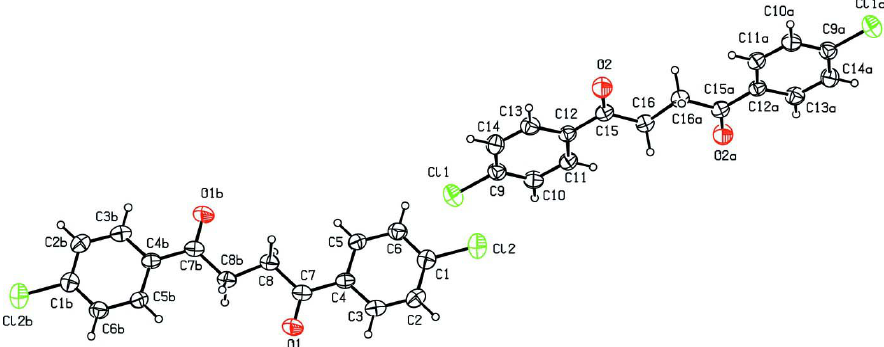
View of the title molecule showing the atom-labelling scheme. The displacement ellipsoids are drawn at the 30% probability level. H atoms are represented by spheres of arbitrary